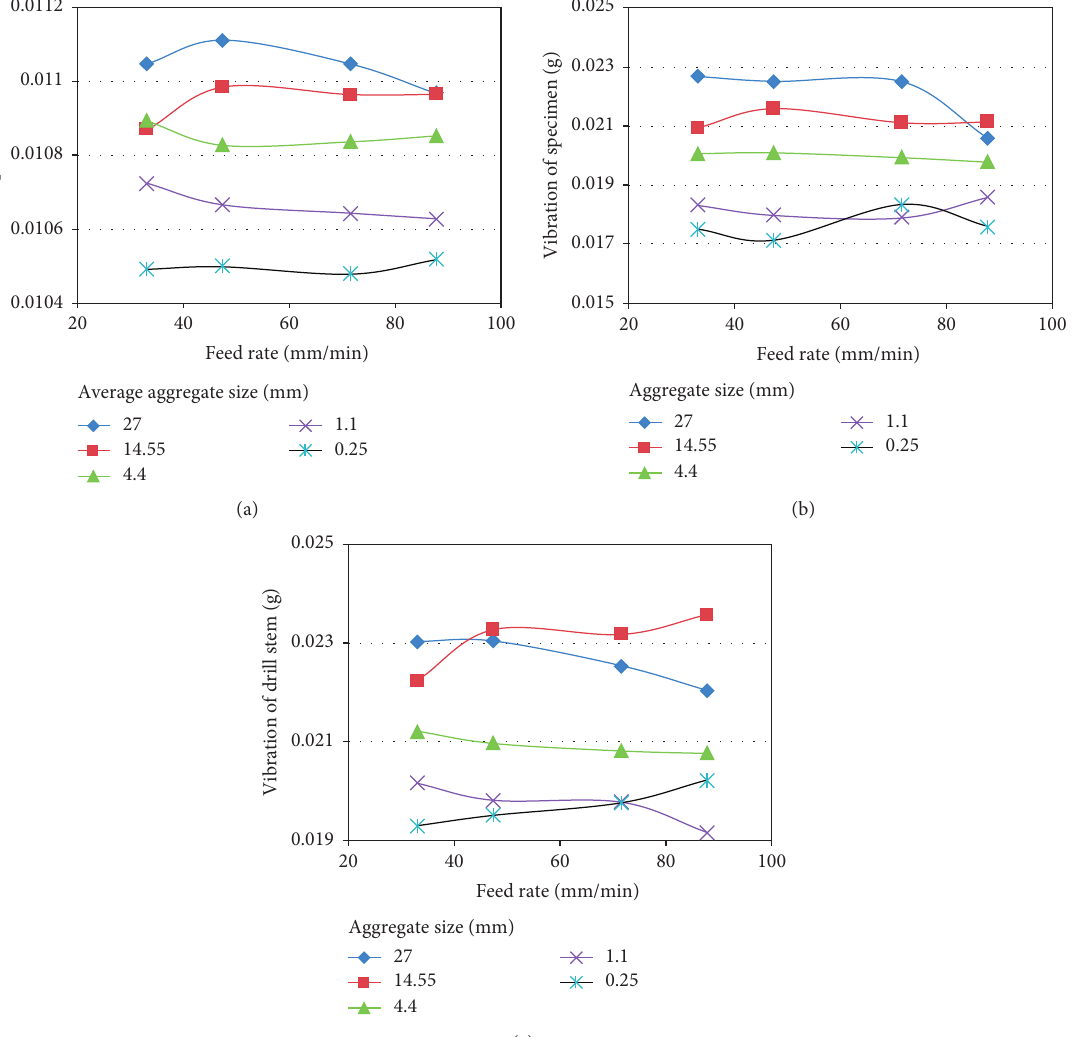
Figure 12: Aptitude patterns of sound and vibration for different aggregate